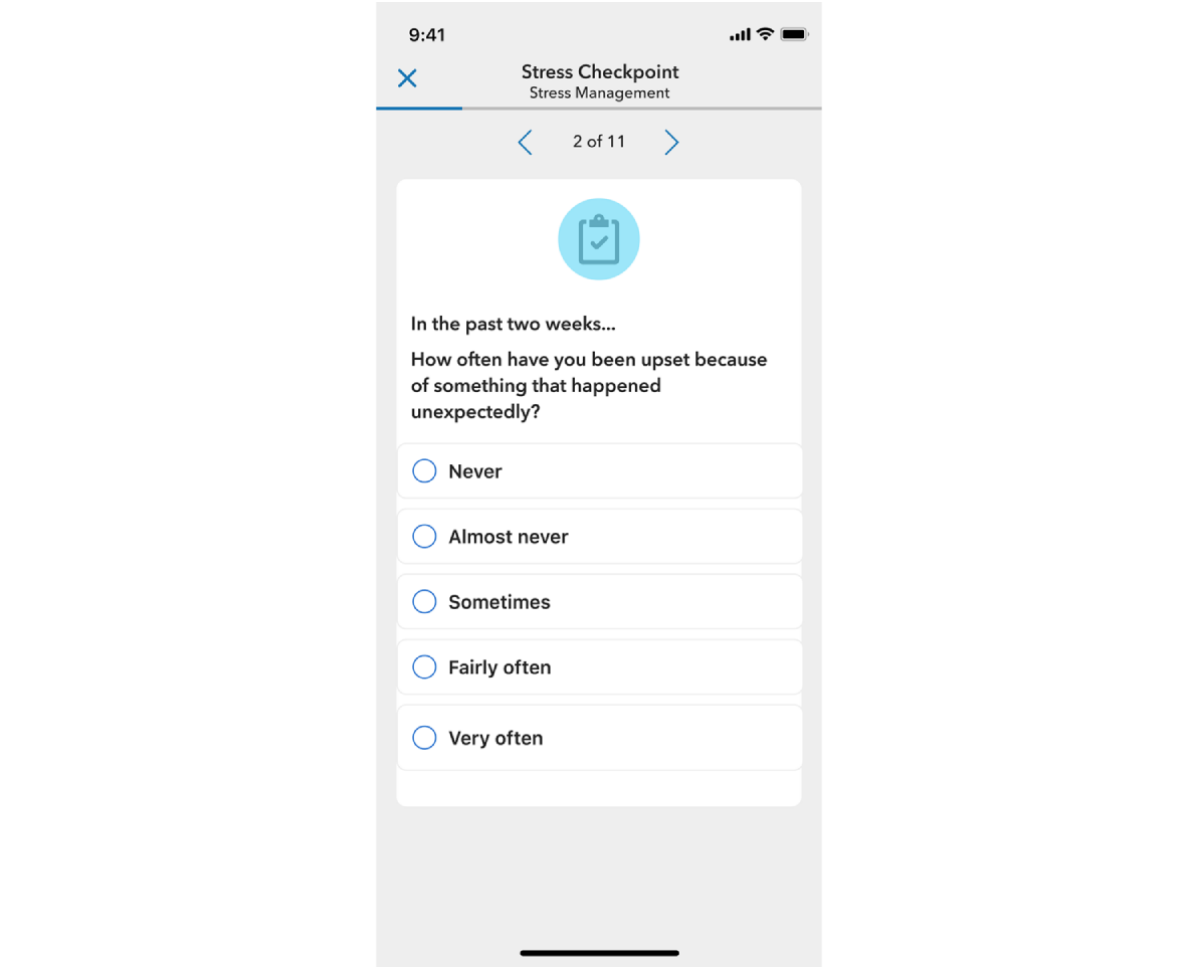
Figure 1. A screenshot of the Perceived Stress Scale-10 assessment in the Vida Health mindfulness-based stress reduction digital